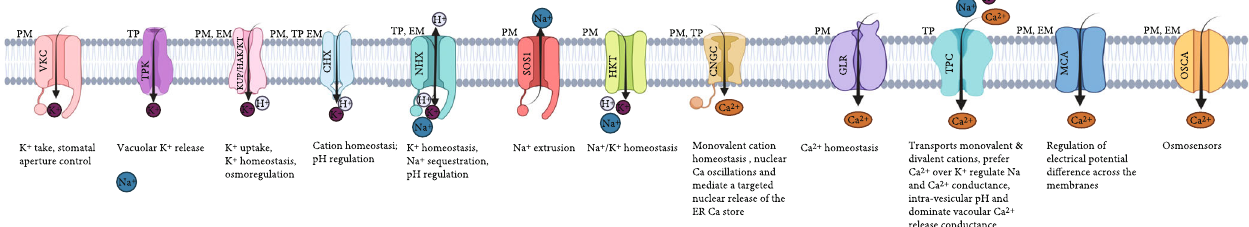
Figure 2: Picture depicting di ff erent transporters and channels with functions responsible for ion homeostasis under salt stress. These transporters and channels are found on plasma membrane (PM), tonoplast (TP), and endomembranes (EM). K + homeostasis-related transporters/channels include voltage-dependent K + channel, two-pore K + channel (TPK), K + uptake permease/high-a ffi nity K + /K + transporter (KUP/HAK/KT), and cation/H + exchanger (CHX). Na + homeostasis-related transporters/channels include Na + /H + exchanger (NHX), salt overly sensitive 1 (SOS1), and high-a ffi nity K + transporter (HKT). Ca 2+ -related transporters/channels include cyclic nucleotide-gated channels (CNGCs), glutamate receptor-like channels (GLRs), two-pore channels (TPCs), mechanosensitive channels (MCAs), and reduced hyperosmolality-induced Ca 2+ increase channels